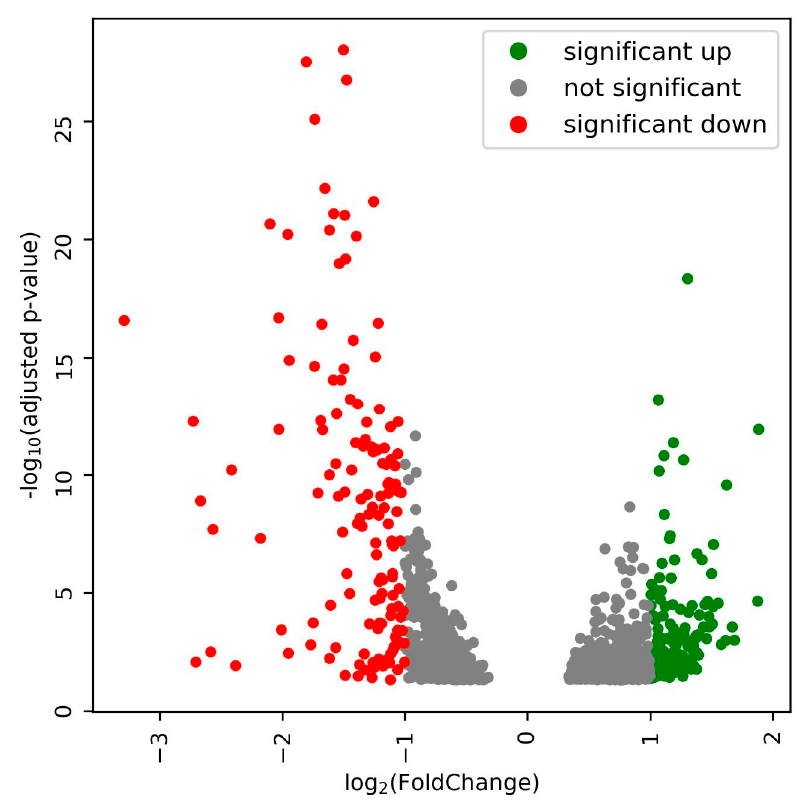
Figure 3. Volcano plot showing differentially expression genes in rhizobium bacteroids in the nodules when the infected plants were exposed to 300 mM NaCl.